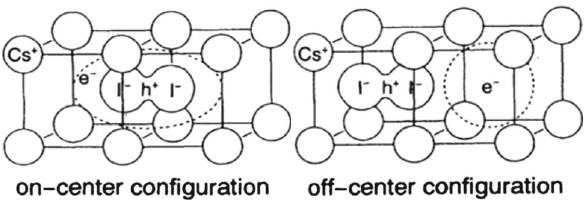
Fig. 10 Two types of self-trapped excitons responsible for the scintil- lation emission in undoped CsI, taken from [25]